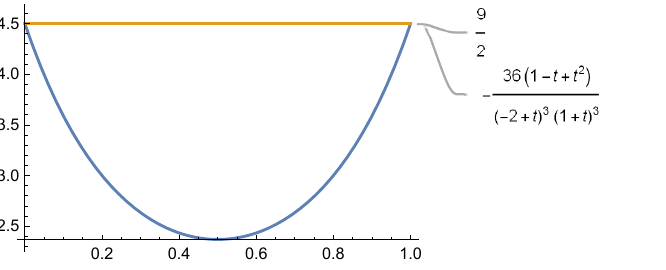
Figure 2. The graph shows that ˘ X ( u , · ) = u 3 is not harmonically convex on [ 1,2 ]